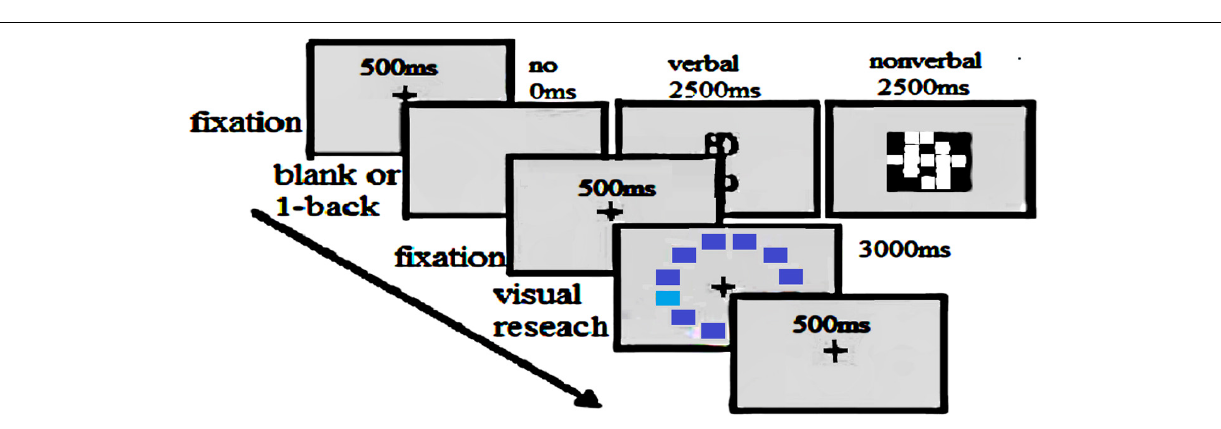
FIGURE 4 | Trial events. Within a block of trials, the visual search task was interwoven with blank displays, displays containing a color word, or displays containing a spatial